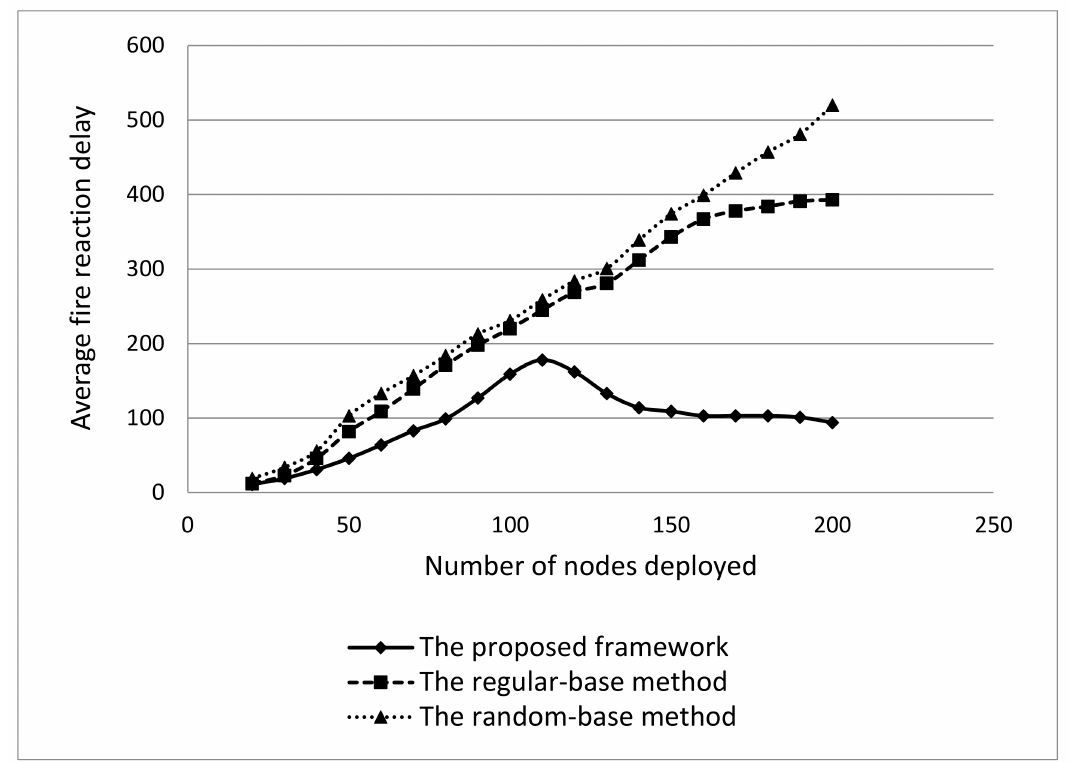
Figure 11. Fires reaction delays of the three compared